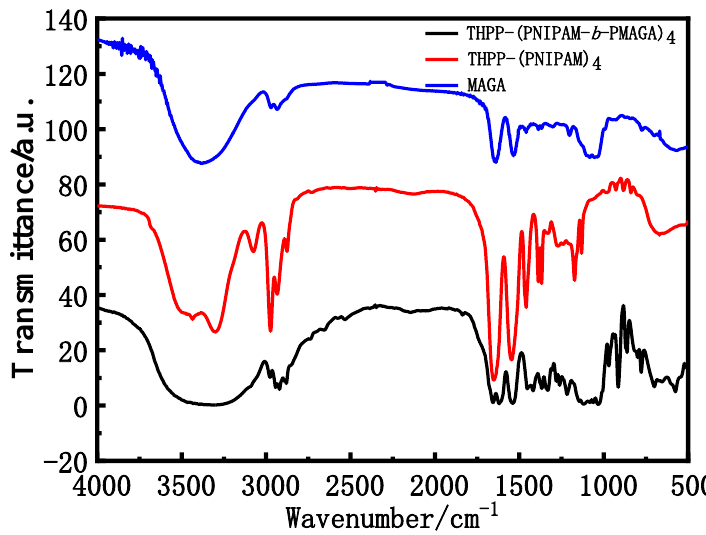
[Figure 1]. 1 HNMR (400 MHz, CDCl 3 ), δ ppm: 8.8–8.2 (porphyrin-H), 6.26 (t,-NH), 4.0 (m,-NCH) [Figure 2c].